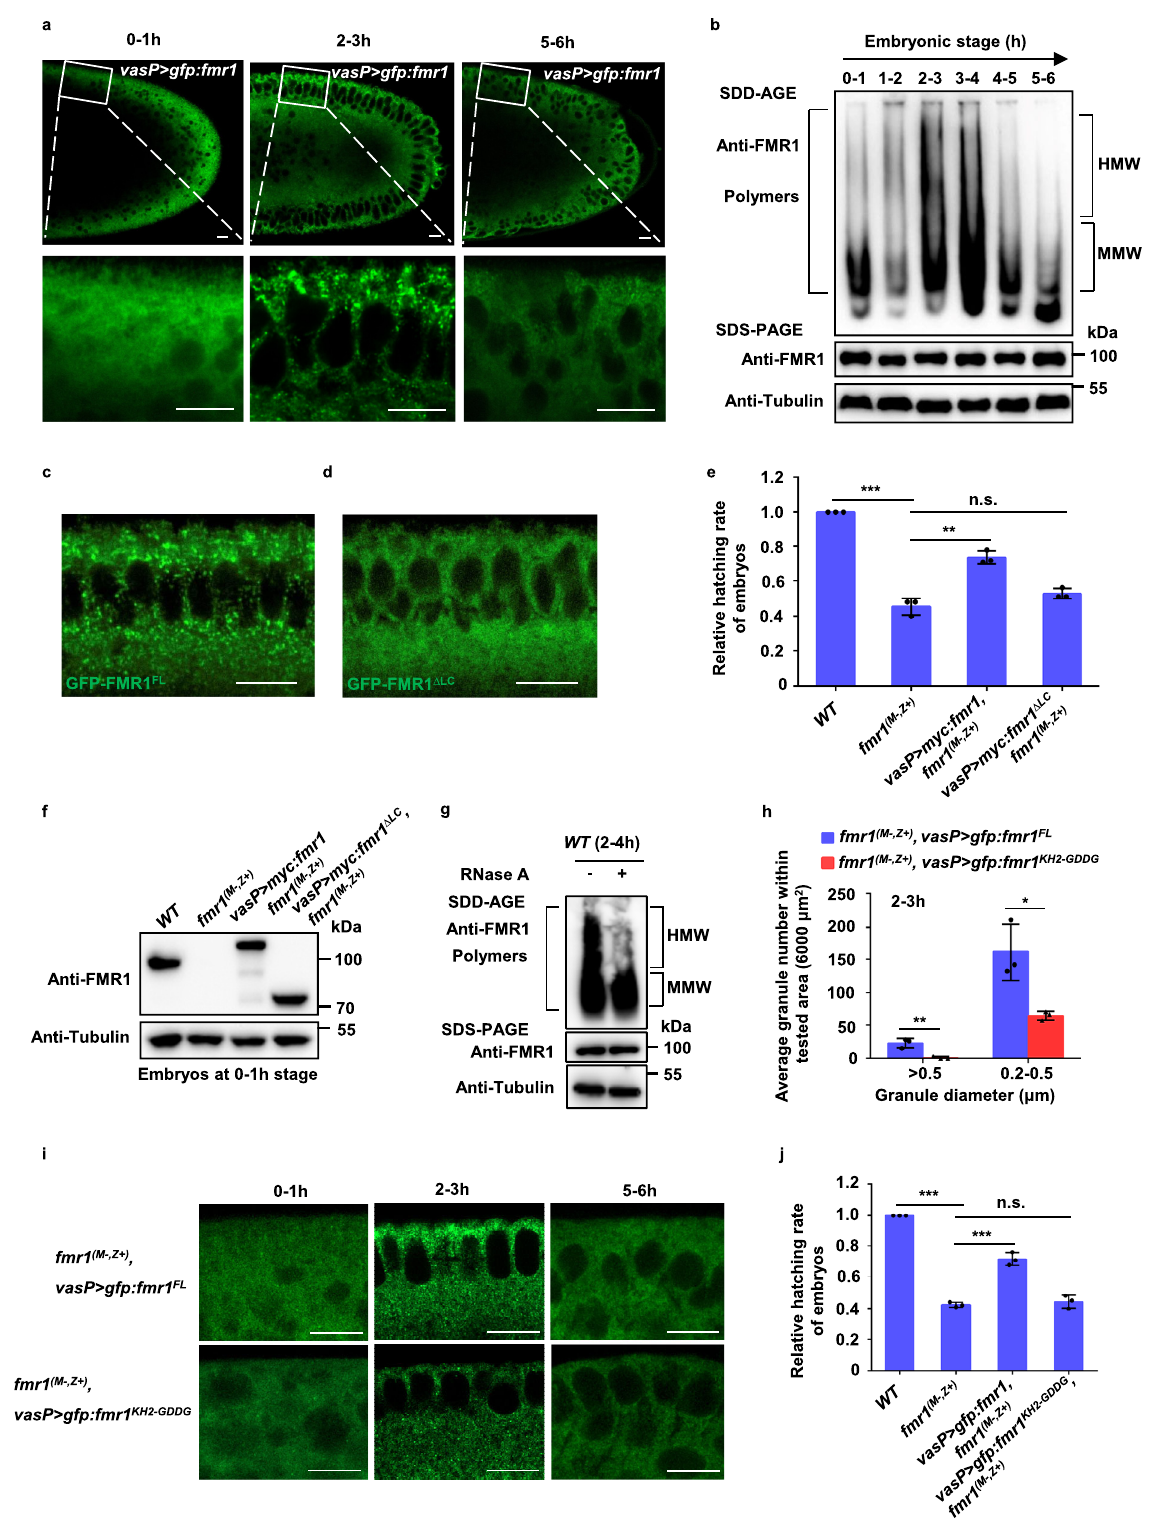
notion that speci fi c interaction between FMR1 and RNAs dynamically regulates the assembly/disassembly switch of FMR1 granules. The m6A modi fi cation regulates the assembly and disassembly of FMR1 granules . To simulate in vivo processes of FMR1 granule formation regulated by its LC domain, we puri fi